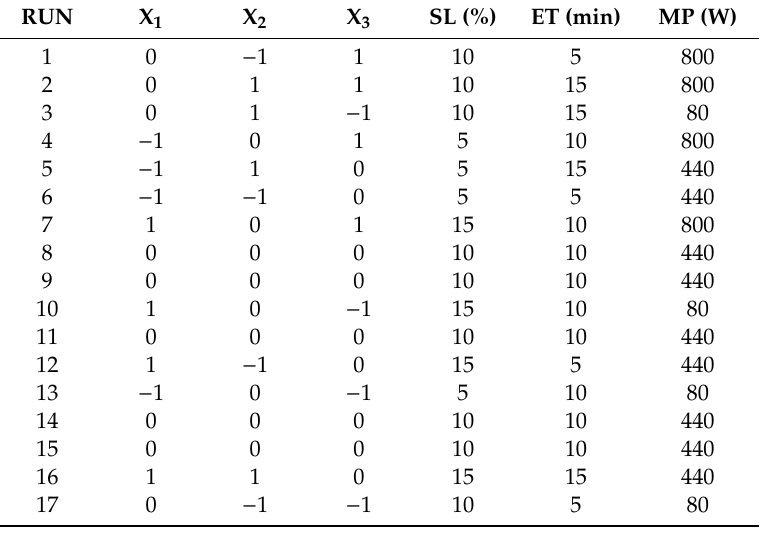
Table 1. Number and Conditions of Experiments According RSM and